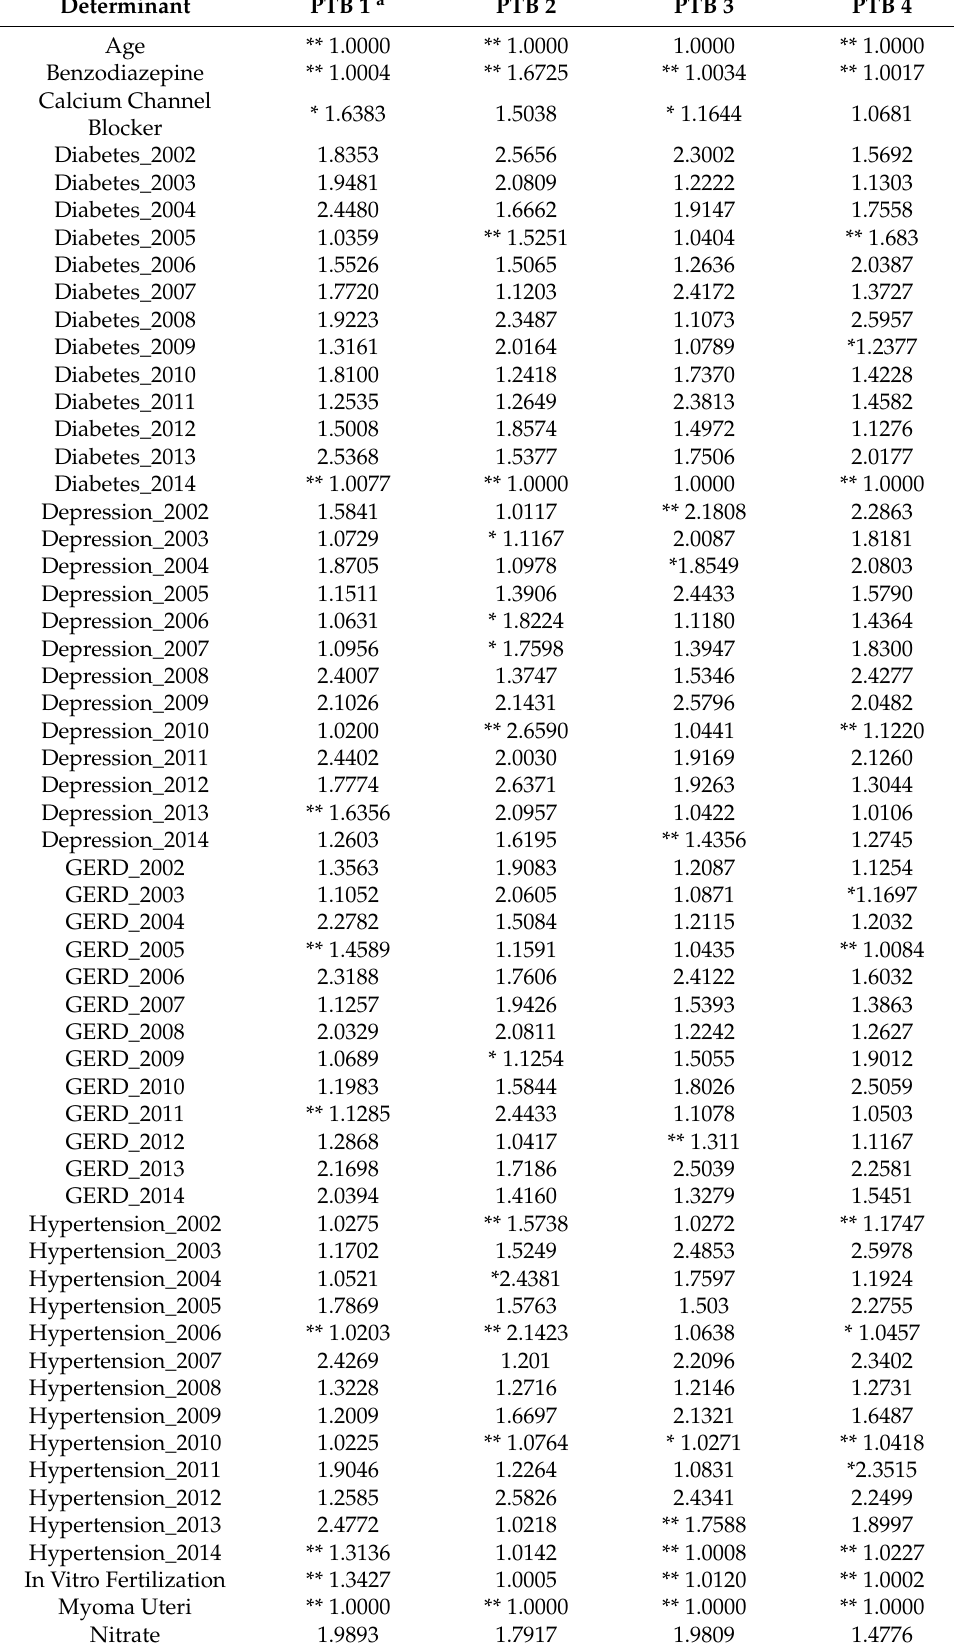
Table 4. Coefficients of determinants from logistic regression for each type of preterm